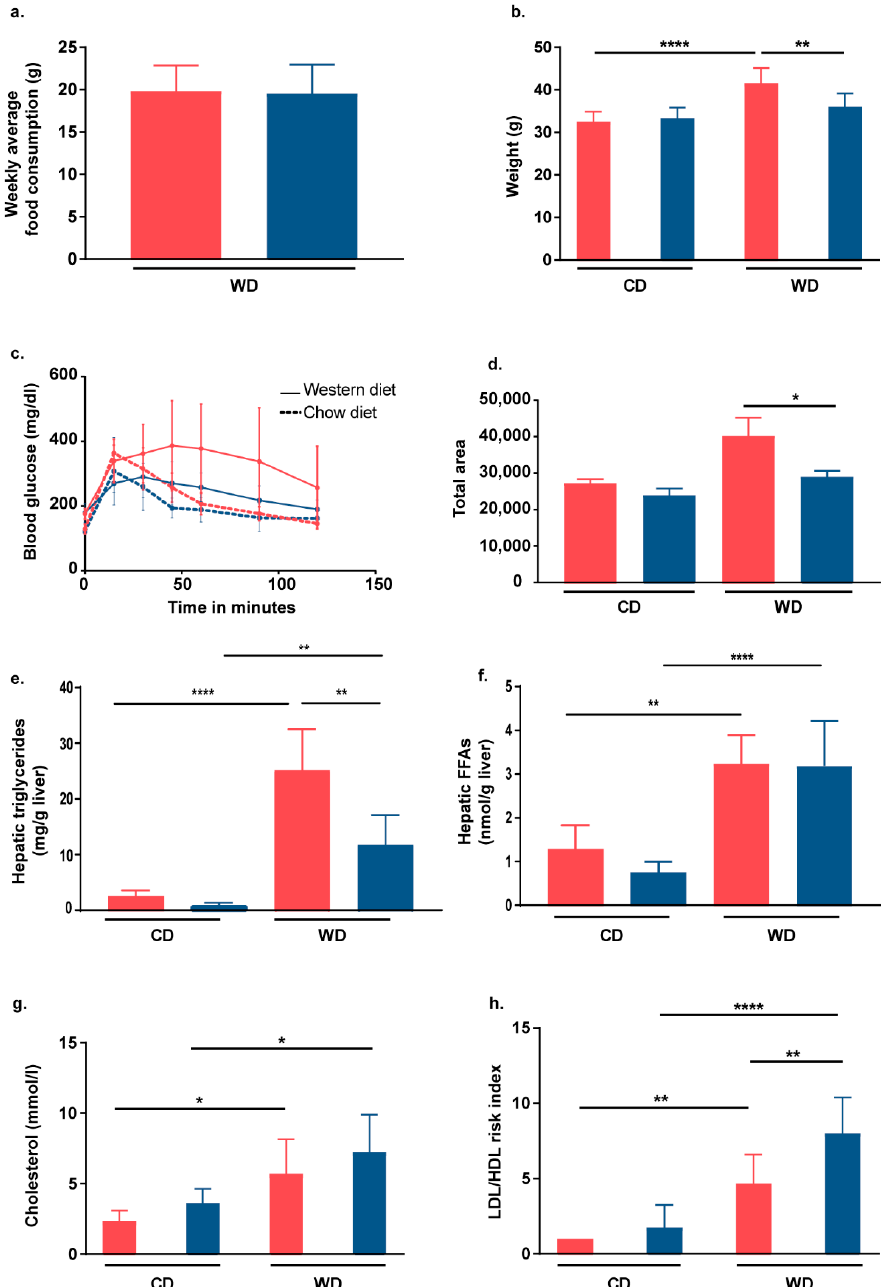
Figure 2. Lsel − / − Keap1 ∆ hepa mice exhibit partial protection from metabolic dysfunction. Lsel − / − Keap1 flx/flx mice (shown in red) and Lsel − / − Keap1 ∆ hepa mice (shown in blue) were fed for 24 weeks with chow diet (CD) or Western diet (WD). ( a ) Weekly average WD consumption of Lsel − / − Keap1 flx/flx mice ( n = 4) and Lsel − / − Keap1 ∆ hepa mice ( n = 4). ( b ) Endpoint body weight, ( c ) endpoint glucose tolerance test (GTT), and ( d ) corresponding quantification as area under curve of Lsel − / − Keap1 flx/flx CD-fed ( n = 6), Lsel − / − Keap1 flx/flx WD-fed ( n = 12), Lsel − / − Keap1 ∆ hepa CD-fed ( n = 4), and Lsel − / − Keap1 ∆ hepa WD-fed mice ( n = 8). ( e ) Liver triglycerides and ( f ) liver free fatty acids (FFA) of Lsel − / − Keap1 flx/flx CD-fed ( n = 5), Lsel − / − Keap1 flx/flx WD-fed ( n = 5), Lsel − / − Keap1 ∆ hepa CD-fed ( n = 4), and Lsel − / − Keap1 ∆ hepa WD-fed mice ( n = 5). ( g ) Serum choles- terol and ( h ) LDL/HDL risk of Lsel − / − Keap1 flx/flx CD-fed ( n = 6), Lsel − / − Keap1 flx/flx WD-fed ( n = 12), Lsel − / − Keap1 ∆ hepa CD-fed ( n = 4), and Lsel − / − Keap1 ∆ hepa WD-fed mice ( n = 8). Statistical significance was calculated either by the one-way ANOVA ( a , b ) or unpaired t -test ( d ). Values are represented either as mean ± SD ( a – c , e – h ) or mean ± SEM ( d ). * p ≤ 0.05, ** p ≤ 0.01, **** p ≤